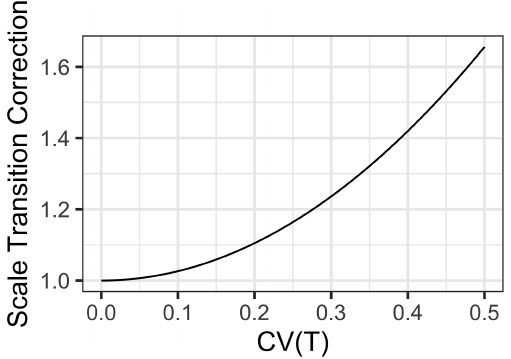
Figure 2. Scale transition correction for Q 10 temperature response scaling given coefficient of variation CV(Temp) from 0 to